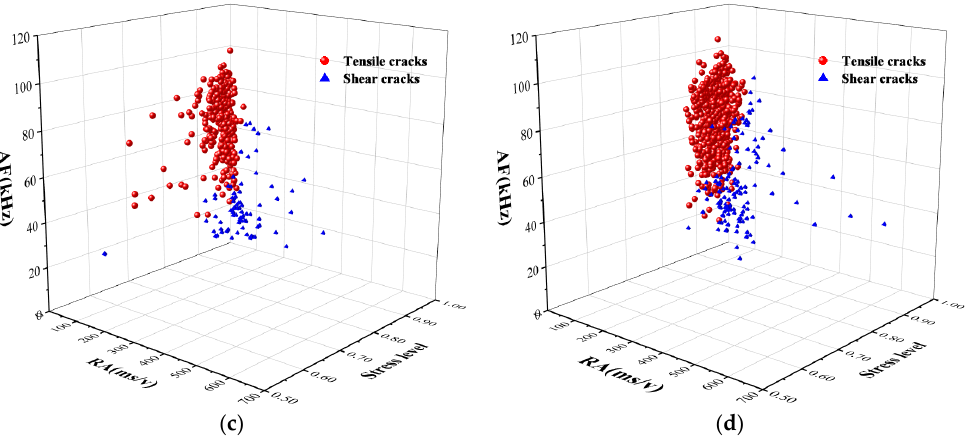
Figure 9. Variation in the tensile cracks and shear cracks of coal samples at different depths with respect to the axial stress level: ( a ) 300 m, ( b ) 600 m, ( c ) 850 m, and ( d ) 1050 m.